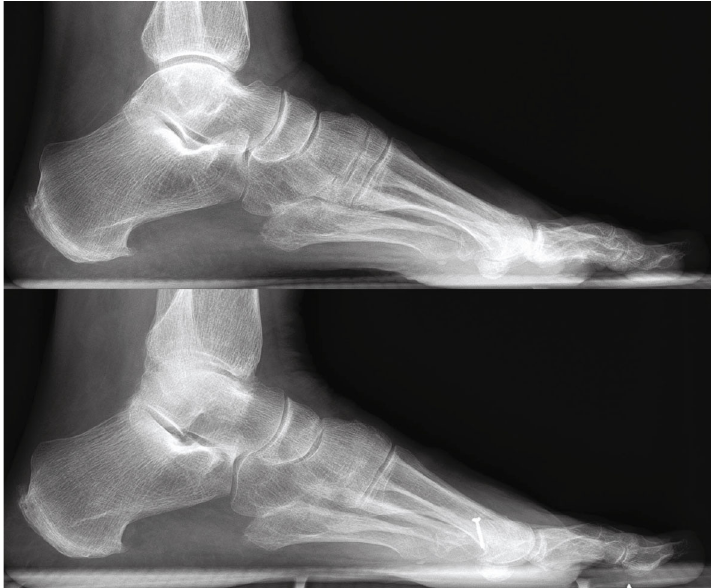
Figure 2: Lateral radiograph prior surgery and at three months